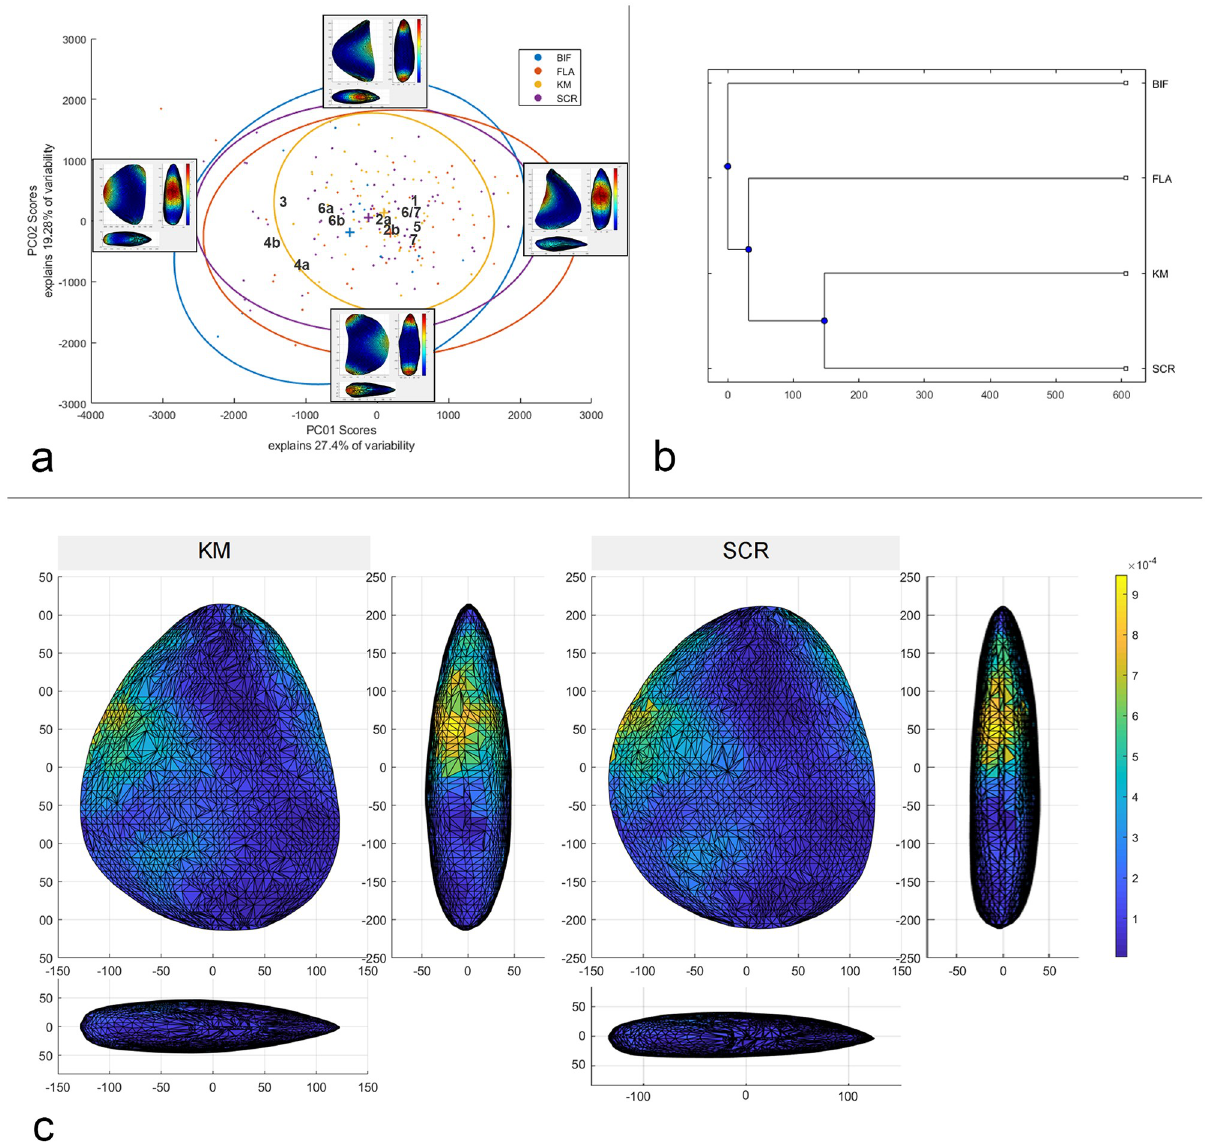
Fig 13. Statistical morphological analysis on 3D models, compared for tool types: scatter plot based on principal component analysis (PCA); the numbers indicate the localization of the techno-functional schemes’ centroids within the PCA (a); group distance between tool types (b) and groups mean comparison between the mean shapes of Keilmesser and scrapers (“KM”: Keilmesser; “SCR”: scrapers; “FLA”: flakes; “BIF”: other bifacial tools).